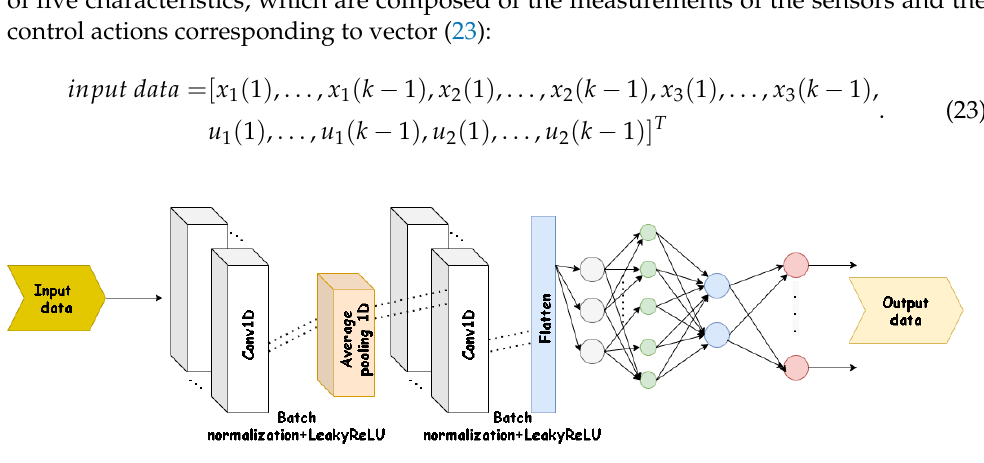
Figure 13. Model to estimate all states.